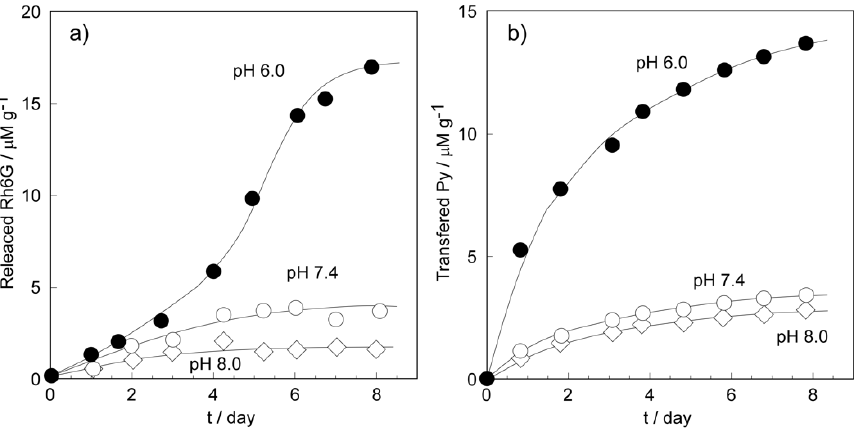
Figure 8. ( a ) The release profile of the hydrophilic Rh6G from the vesicle interior to the outer aqueous phase, and ( b ) the transfer of hydrophobic Py from the bilayer membrane of CaCO 3 -coated vesicles to that of the pure azolectin vesicle under the various pH conditions.